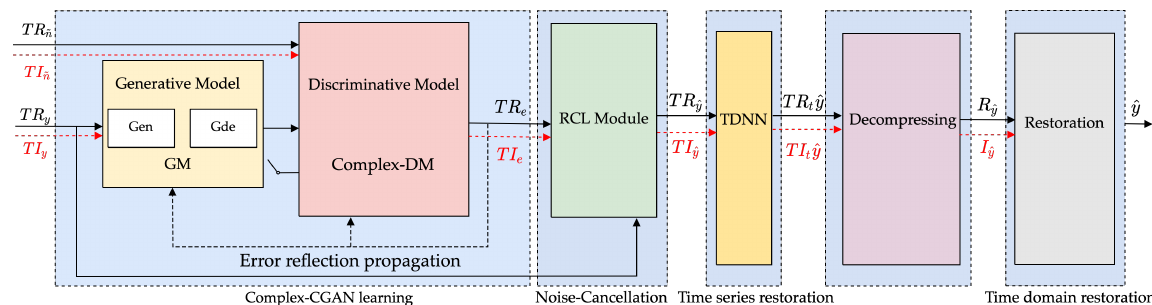
Figure 8. Structural components of the noise-reduction learning model.